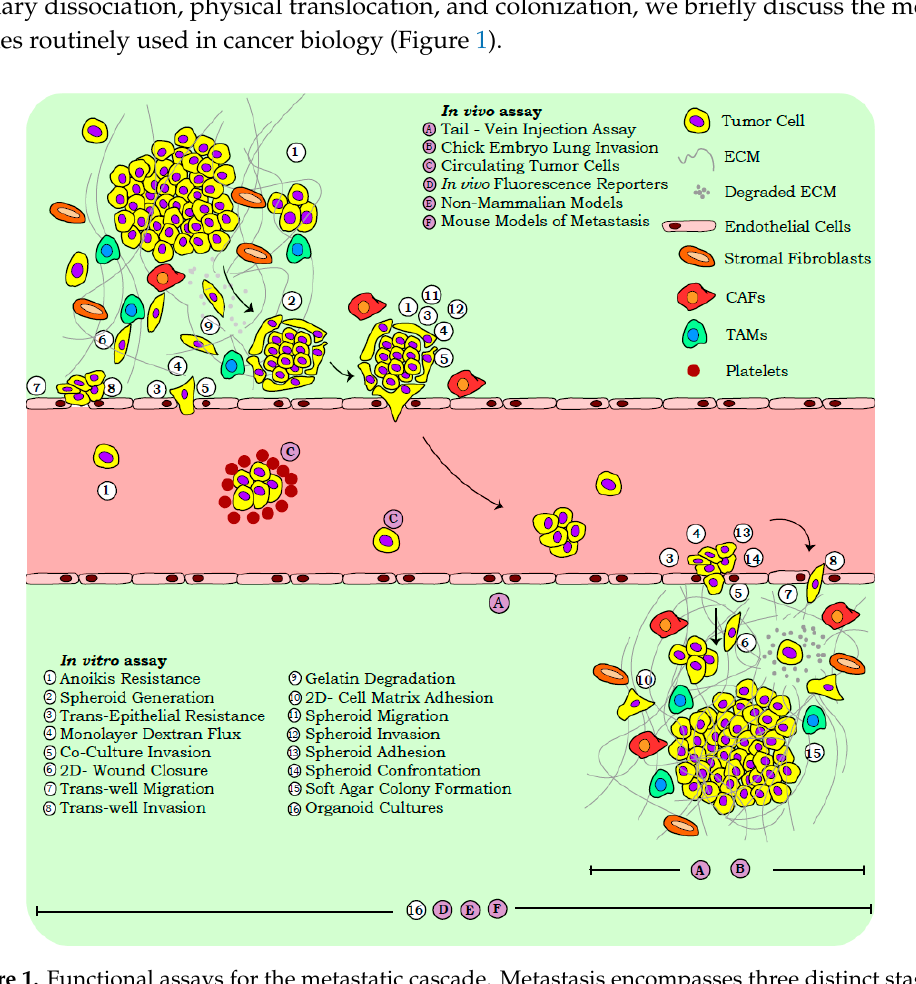
Figure 1. Functional assays for the metastatic cascade. Metastasis encompasses three distinct stages, viz. primary dissociation, physical translocation, and colonization. The interplay of complex processes severs cells from the primary tumor; these cells proliferate, migrate, and invade through the tissue matrix to initiate hematogenous or lymphatic